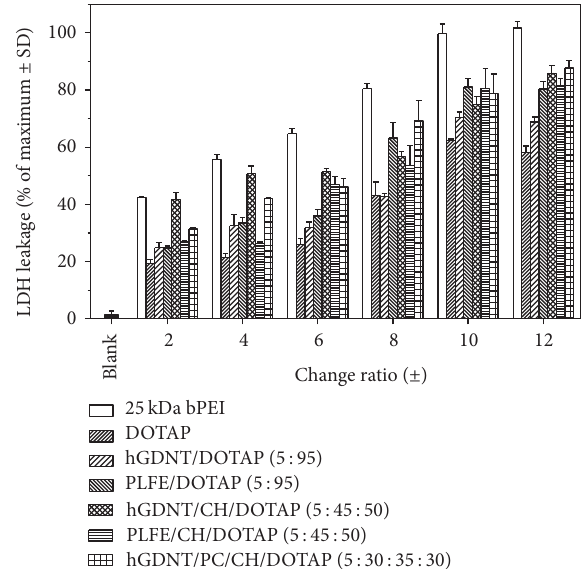
Figure 13: LDH assay of tetraether lipid containing lipoplexes and polyplexes.